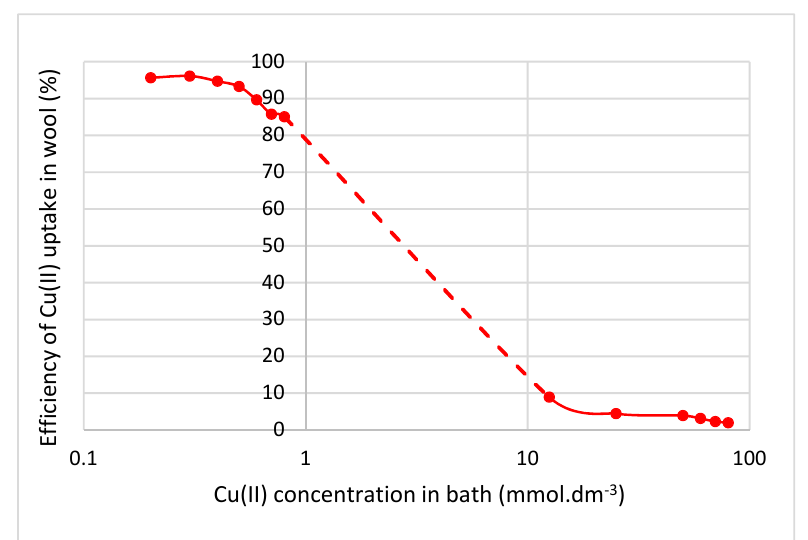
Figure 6. Efficiency variation of Cu(II) uptake by wool depending on Cu(II) concentration in bath for non-irradiated wool.